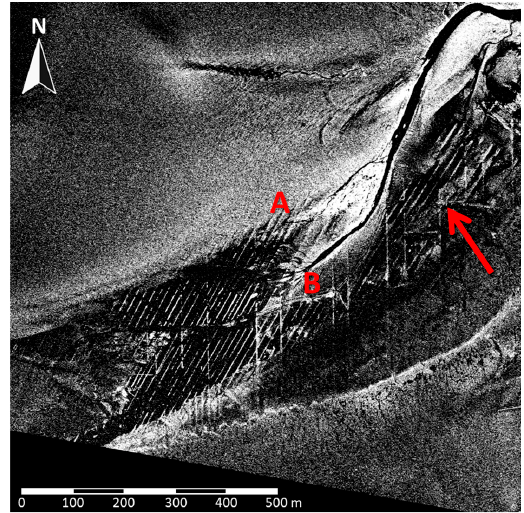
Figure 11. Subsection (1000 m × 1000 m) of a TanDEM-X staring-spotlight scene acquired on 21 November 2014, north of Pellworm Island. Letters (A) and (B) are described in the text. The photographs shown in Figure 10 were taken in the area marked by the red arrow. © DLR 2014. An example of very high resolution SAR imagery of the same site (corresponding to the lower right panel of Figure 9) is shown in Figure 11. Inserted is a red arrow that marks the location, at which the photographs of Figure 10 were taken. This small (1000 m × 1000 m) section of a TanDEM-X staring spotlight scene was acquired on 21 November 2014, at 05:42 UTC (low tide) and shows many bright and dark parallel lines all over the image center. The distance of those lines is between 10 m